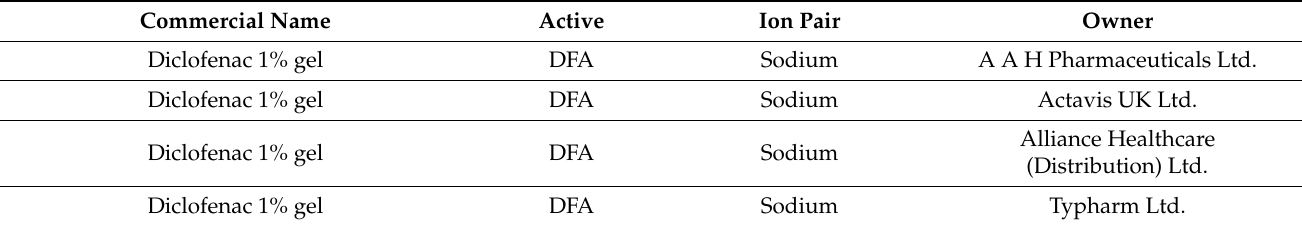
Table 22. Commercial applications of DIC and counter ions sodium, epolamine and